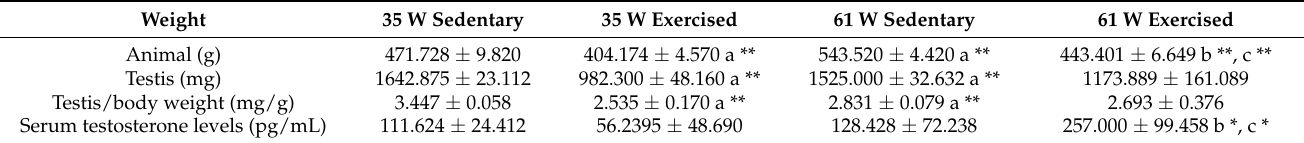
Table 1. Effect of age and exercise training on animals’ body weight and testes–body weight ratios, and on circulating testosterone. Results are expressed as the mean ± SEM ( n = 8 for 35 W Sedentary; n = 9 for 35 W Exercised, 61 W Sedentary and 61 W Exercised). * p < 0.05; ** p < 0.01. a—Significantly different from 35 W Sedentary; b—significantly different from 61 W Sedentary; c—significantly different from 35 W